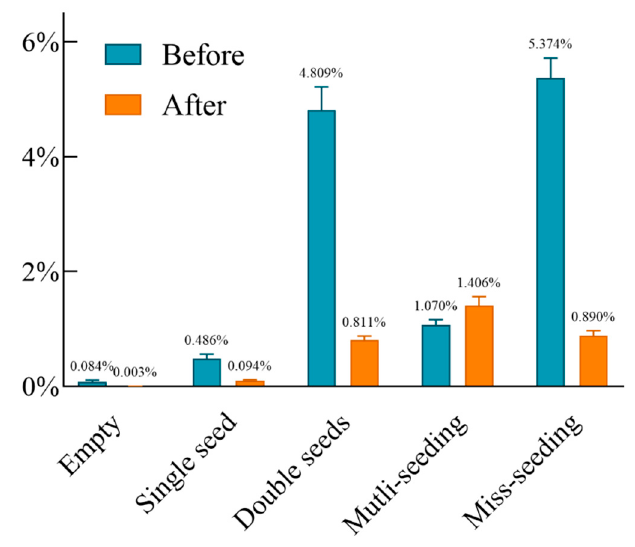
Figure 28. Comparison of the effect before and after complementary seeding.